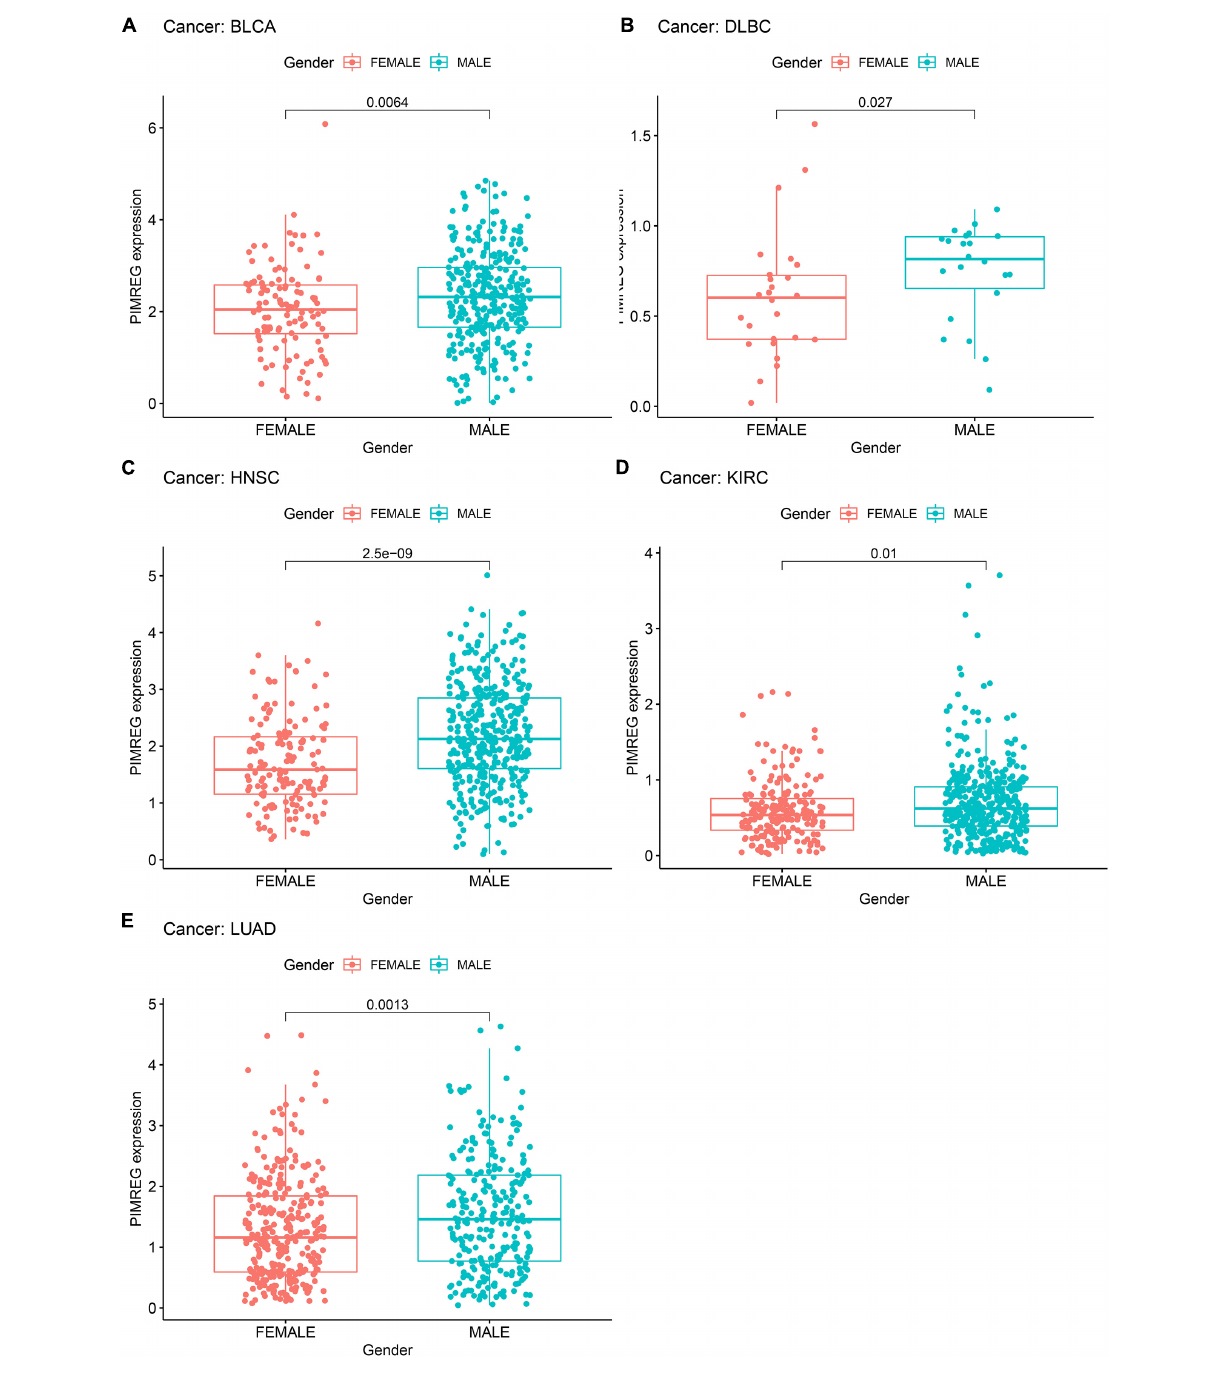
KIRC, LGG, LUAD, LUSC, MESO, OV, PAAD, PRAD, SARC, SKCM, STAD, TGCT, THCA, UCEC, and UCS, while negatively correlated with TMB in DLBC, ESCA and THYM ( Table 1 and Figure 10A ). We further found that the expression of PIMREG